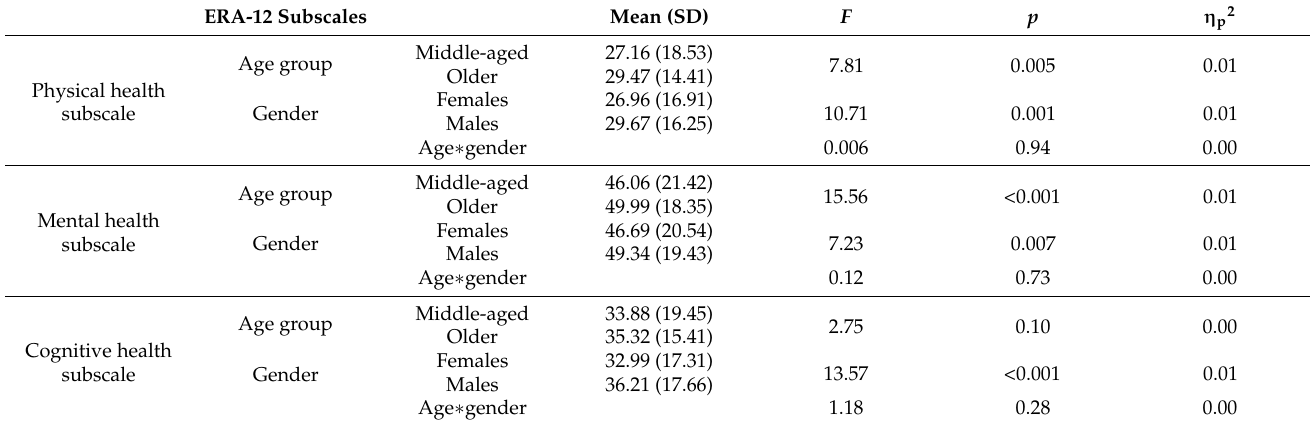
Table 4. Relationships between age, gender, and ERA-12-J subscale